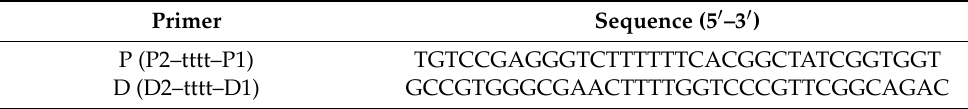
Table 1. LMTIA primers for the internal transcribed spacer of